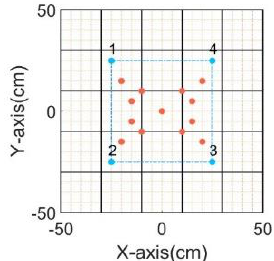
Figure 16. Schematic diagram of the experimental scheme. Blue dots indicate the sensor positions, red dots indicate the impact points, the black line at the edge indicates the boundary of the test piece, and the black line inside indicates positions of the stiffeners.